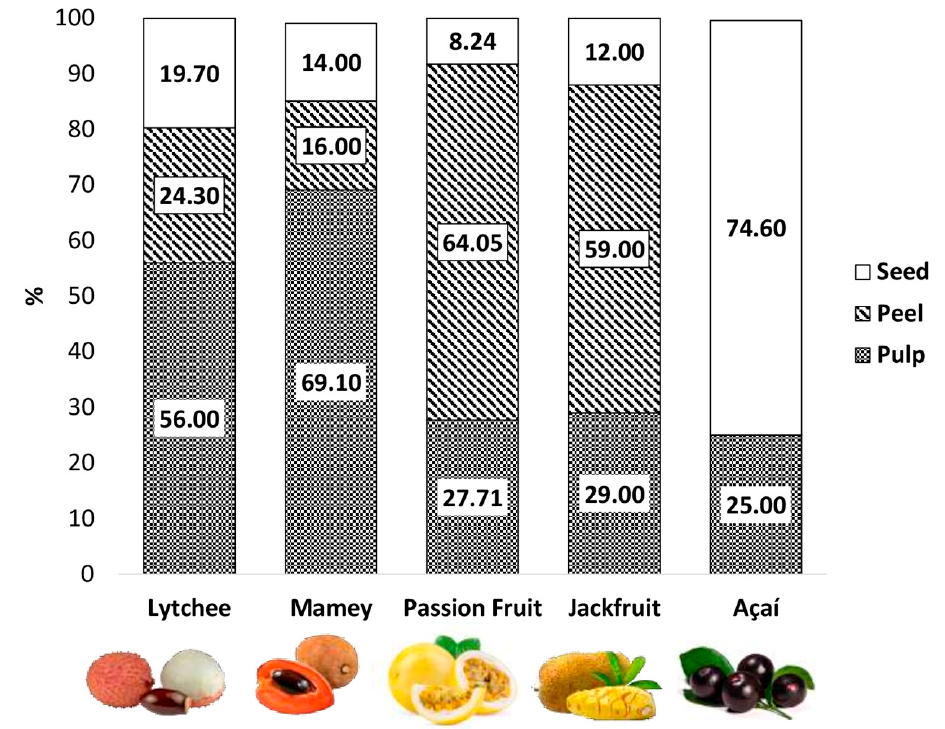
Figure 1. Percentage of pulp, seed, and peel in lesser-consumed tropical fruits (lychee [39], mamey [43], passion fruit [36], jackfruit [41] and açaí [32]).